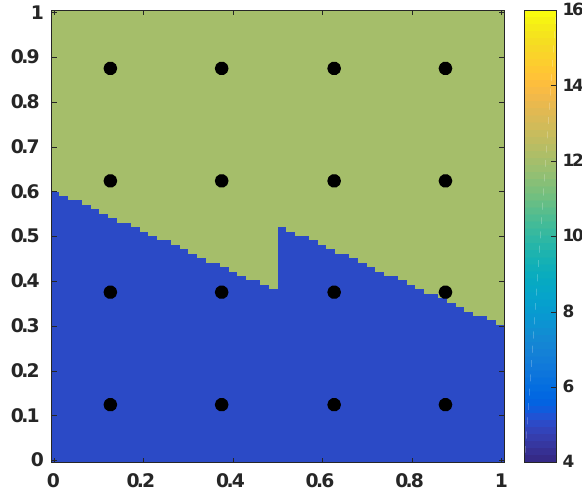
Figure 2. True permeability of the five-parameter nonlinear prob- lem with dots representing the observation